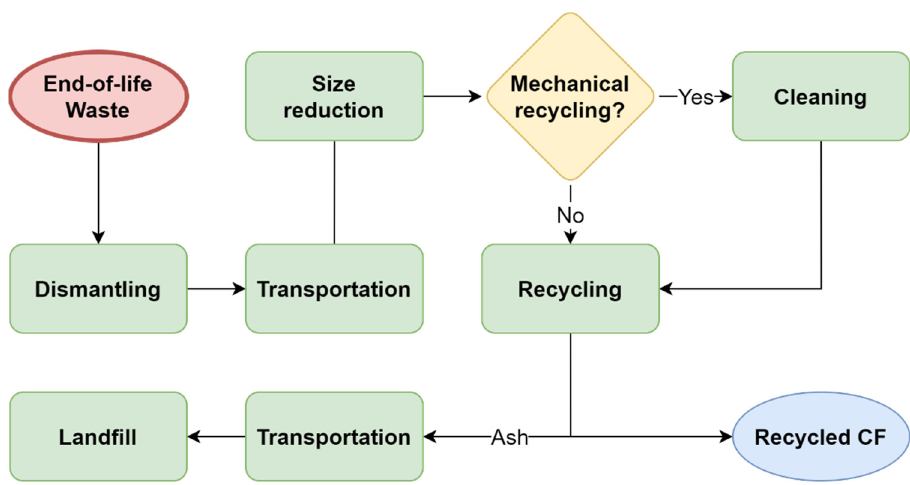
Figure 1. Recycling process flow of carbon fiber campsites